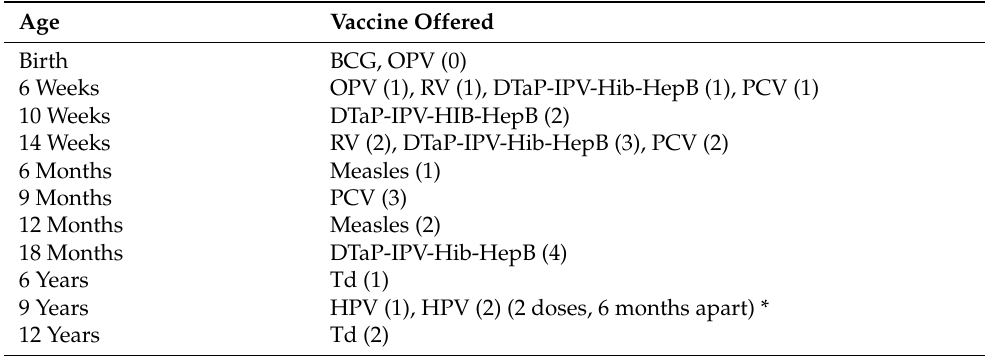
Table 1. Current routine childhood immunisation schedule in South